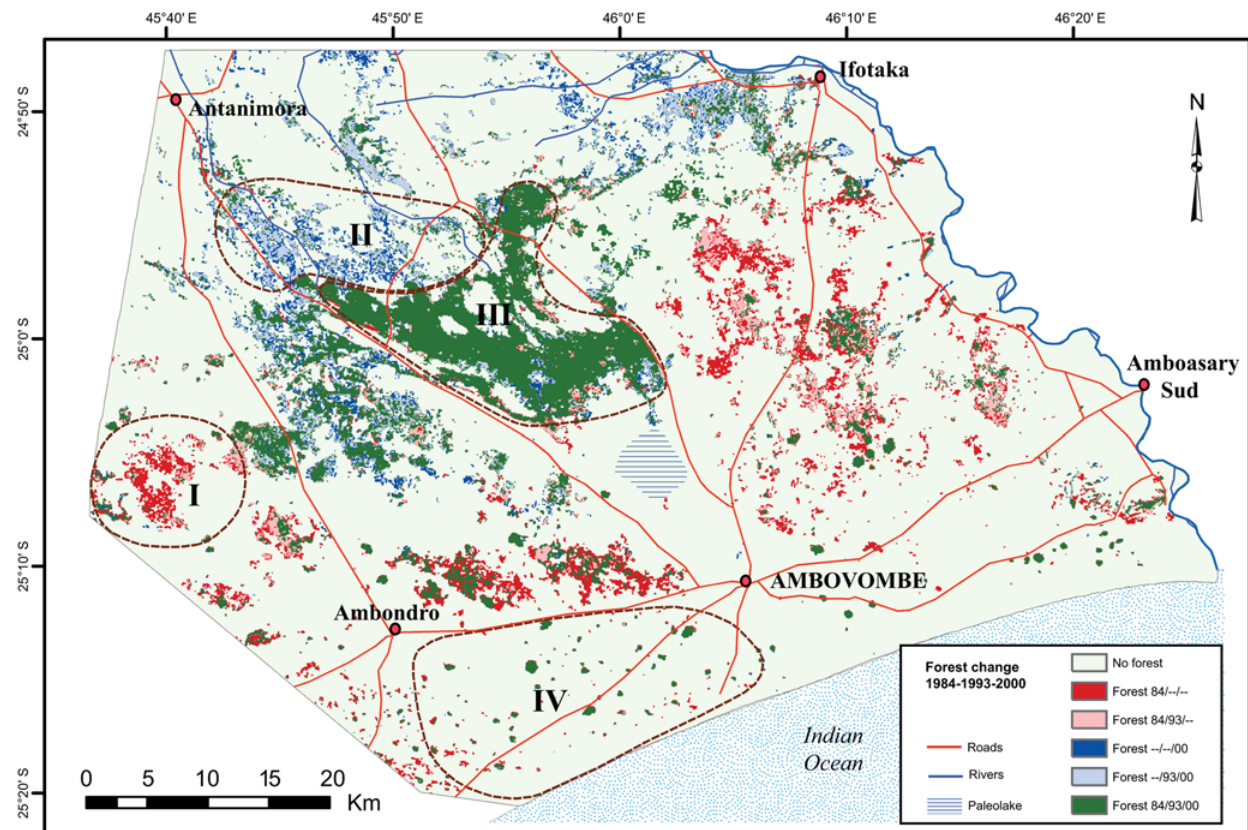
Figure 5. Time-series analysis of changes in forest cover based on satellite images (dry season synoptic views from 25 June 1984 (Landsat 5 TM), 15 April 1993 (Landsat TM) and 28 May 2000 (Landsat 7 ETM + ) from Androy, southern Madagascar. Three patterns of forest cover change between 1984 and 2000 is presented: 1) red-reddish areas-loss of forest, 2) blue-bluish areas–increase of forest cover and 3) green areas–stable forest.